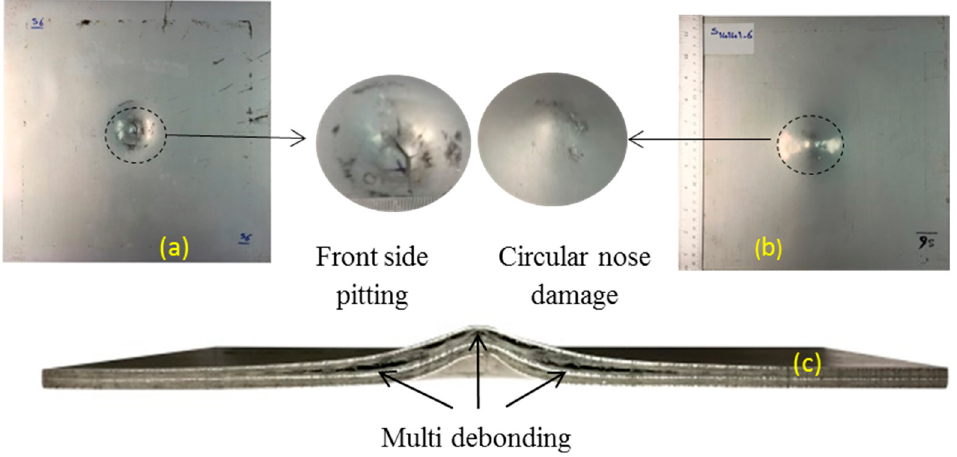
Figure 7. Sample S14141-6 in impulse 6.7 N.s ( a ) front face, ( b ) back face, ( c ) cross section.